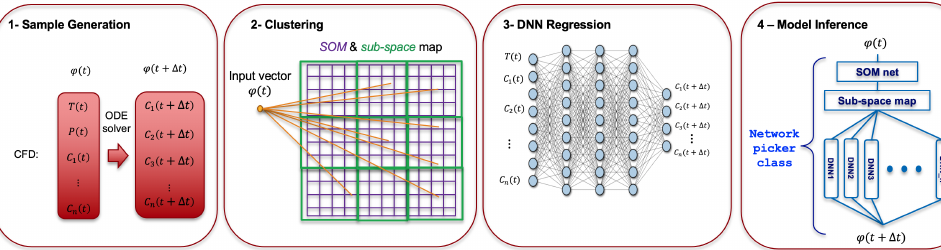
Figure 1. The overview of the Learned Intelligent Tabulation (LIT) method involving the use of unsupervised learning to reduce dimensionality of the data (Step 2), performing DNN regression task on each reduced compositional space (Step 3) and finally, model inference coupled to a CFD code (Step